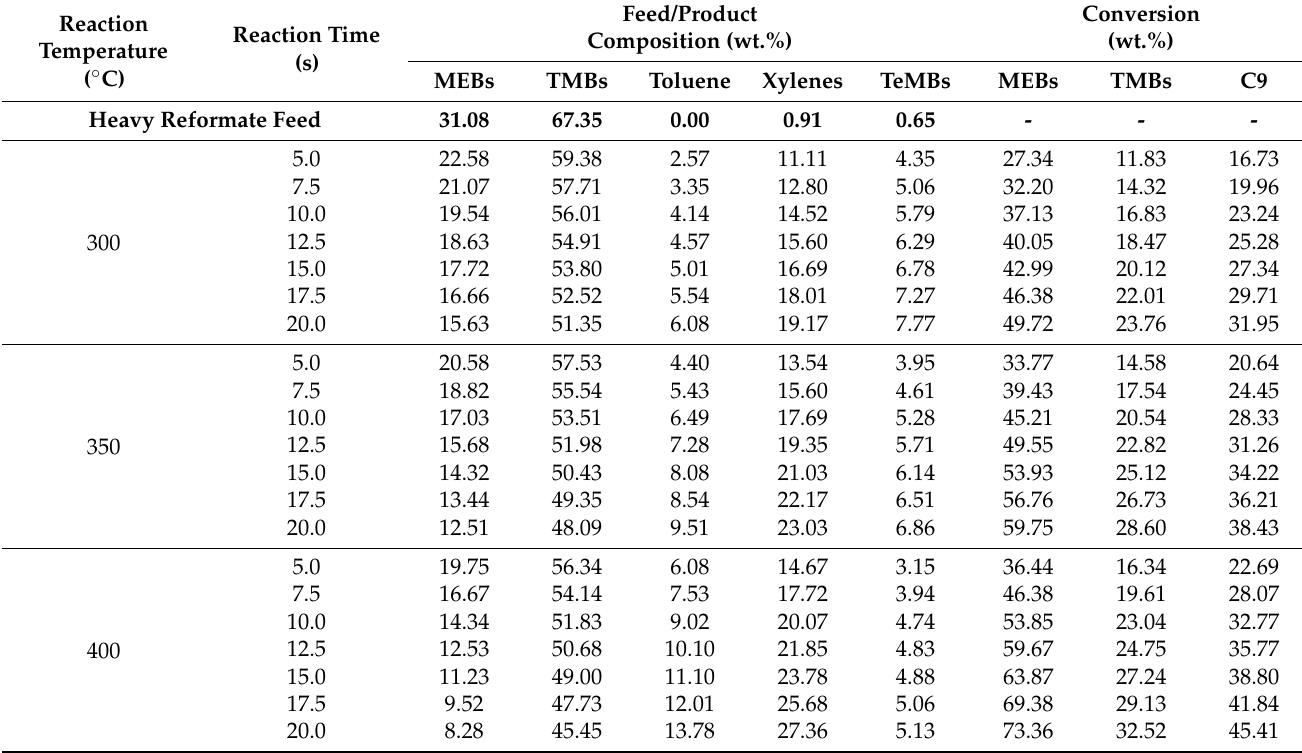
Table 3. Composition of feed and products obtained at various reaction temperatures and